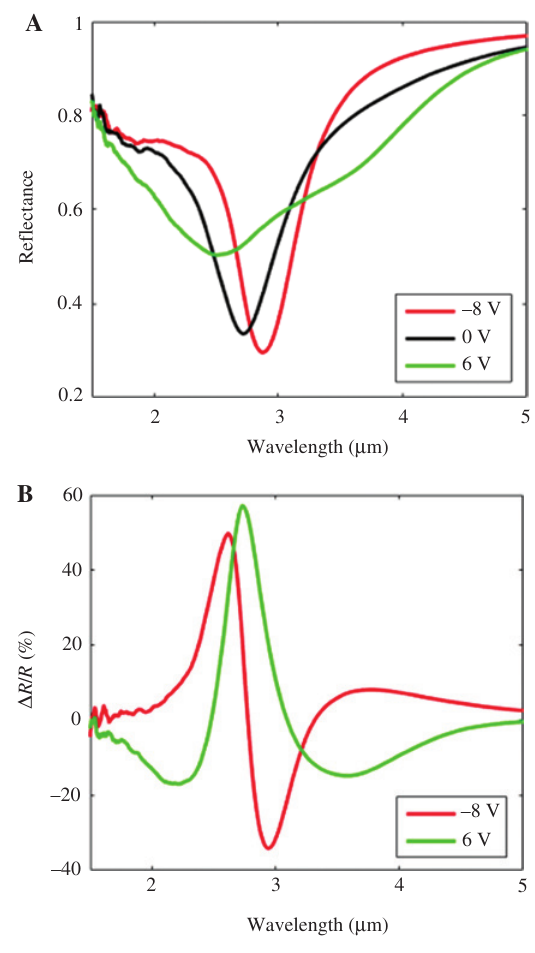
Figure 9: The experimental demonstration of the active tuning for device D2 (P = 1.0 μ m, W = 405